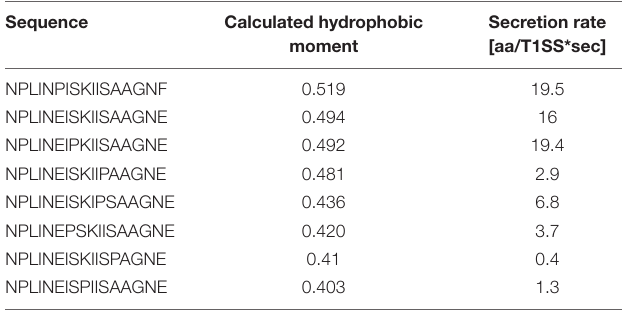
TABLE 3 | Hydrophobic moments of the single side mutations of the predicted amphipathic α -helix. Sequence